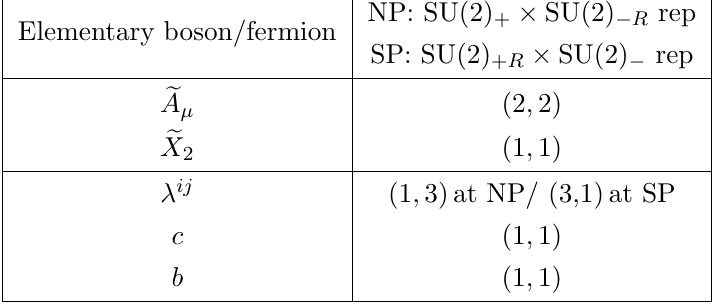
Table 5 . The twisted representation labels of the elementary bosons and fermions of the vector